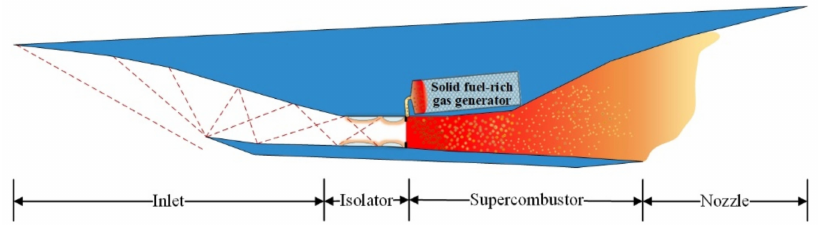
Figure 2. Schematic of the solid scramjet proposed by Xia et